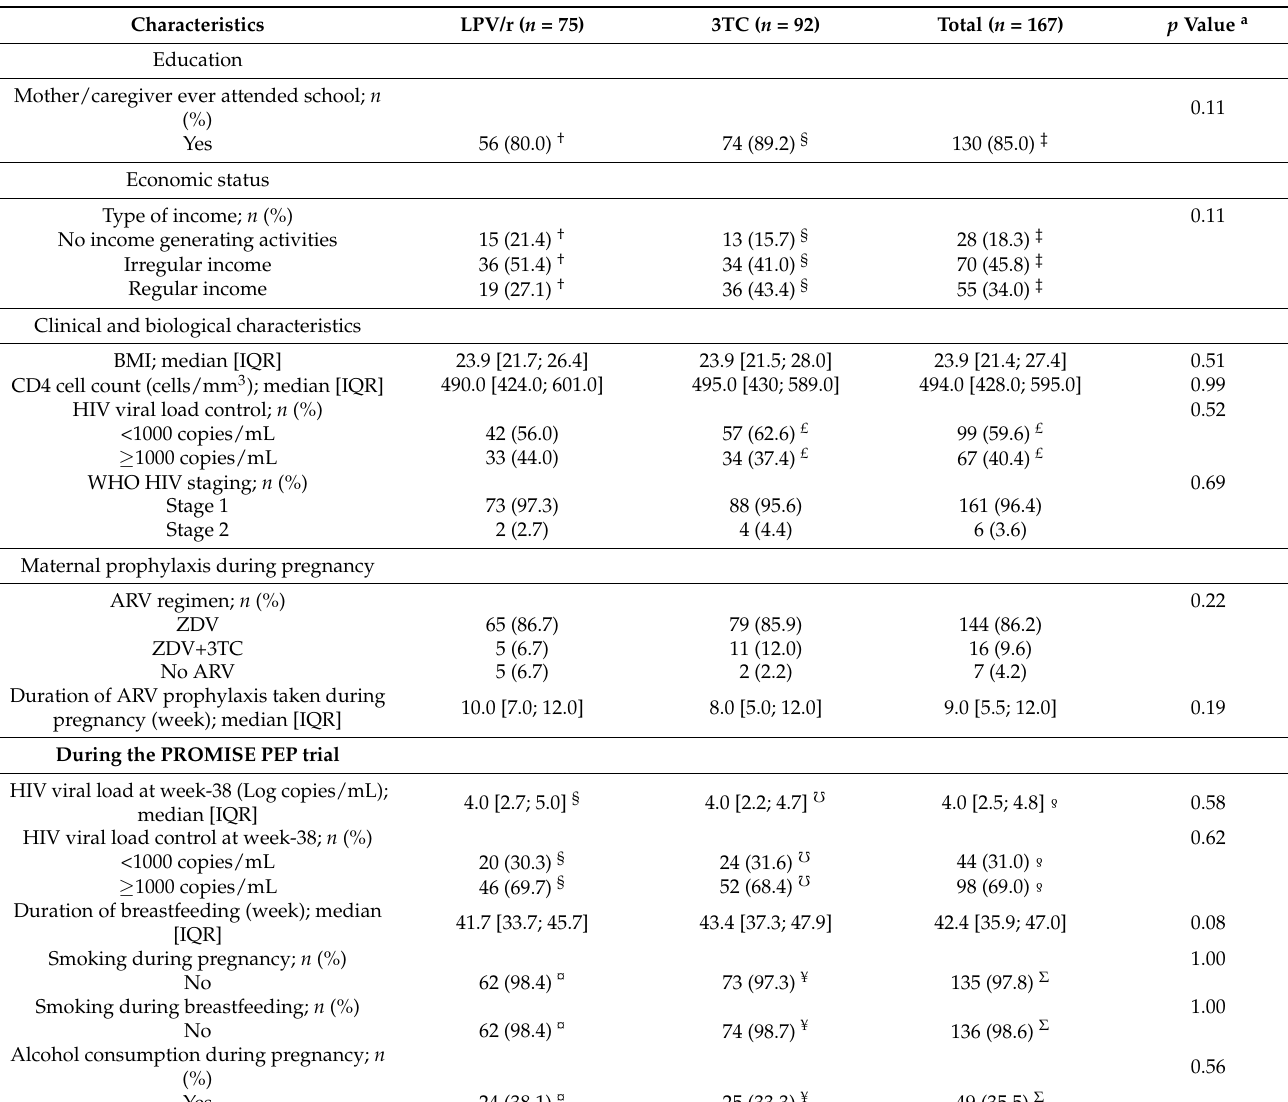
† five missing values, § nine missing values, ‡ fourteen missing values, £ one missing value,